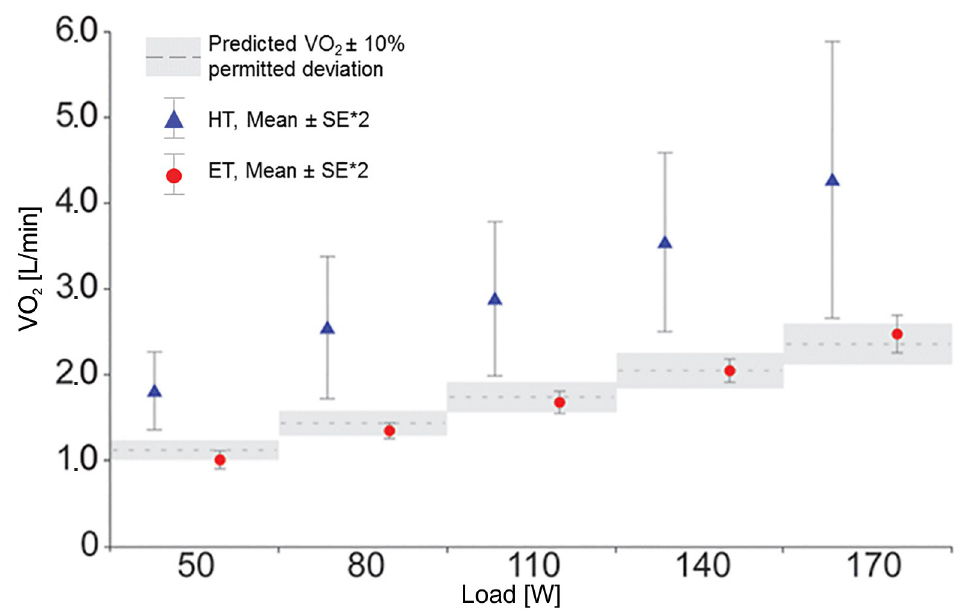
Fig 4. Comparison between HT and ET at FIO 2 = 78.57%. The dotted lines represent the _ VO man according to Wasserman et al. (2012). The grey block around the dotted line represents the permitted Deviation of ± 10% (see Table 2). The mean values of HT and ET at each load-level are shown with the double standard error to confidence of the plausibility of _ VO predicted. Abbreviations: HT Haldane Transformation, ET Eschenbacher 2 Transformation.